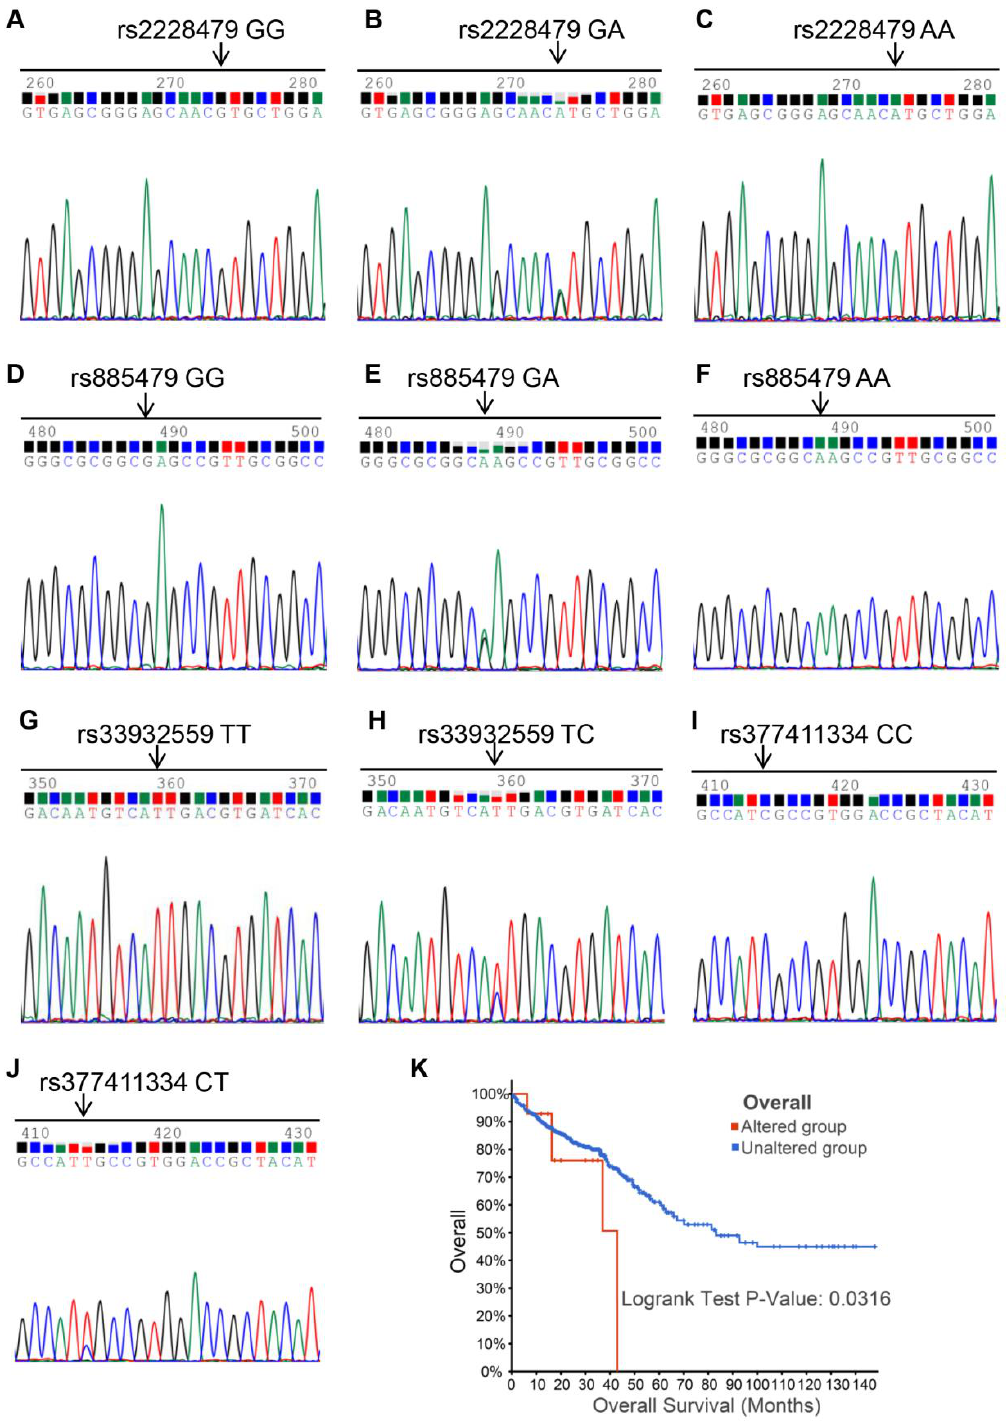
Figure 6. Chromatograph of sequencing of MC1R coding sequence. ( A ) homozygotic type of SNP locus rs2228479; ( B ) and ( C ) heterozygous type of SNP locus rs2228479; ( D ) homozygotic type of SNP locus rs885479; ( E ) and ( F ) heterozygous type of SNP locus rs885479; ( G ) homozygotic type of SNP locus rs33932559; ( H ) heterozygous type of SNP locus rs33932559; ( I ) homozygotic type of SNP locus rs377411334; ( J ) heterozygous type of SNP locus rs377411334. ( K ) Overall survival